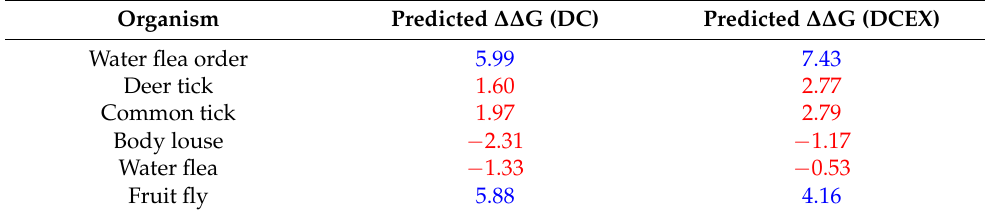
Table 4. Predicted ∆∆ G values of SARS-CoV-2 Wuhan-Hu-1 S-protein: ectoparasite ACE complexes for direct contact (DC) residues and also for direct contact plus extended (DCEX) residues. Ectopara- sites are categorised according to risk of infection by SARS-CoV-2, with ∆∆ G ≤ 3.72 being at risk (red), and ∆∆ G > 3.72 not at risk